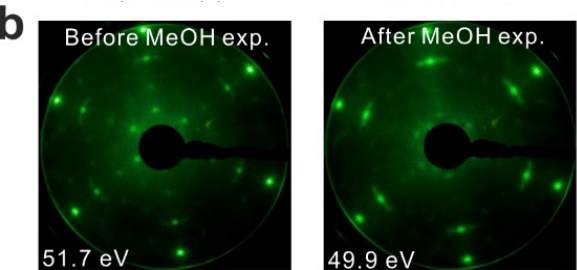
/Pt(111) surface after x